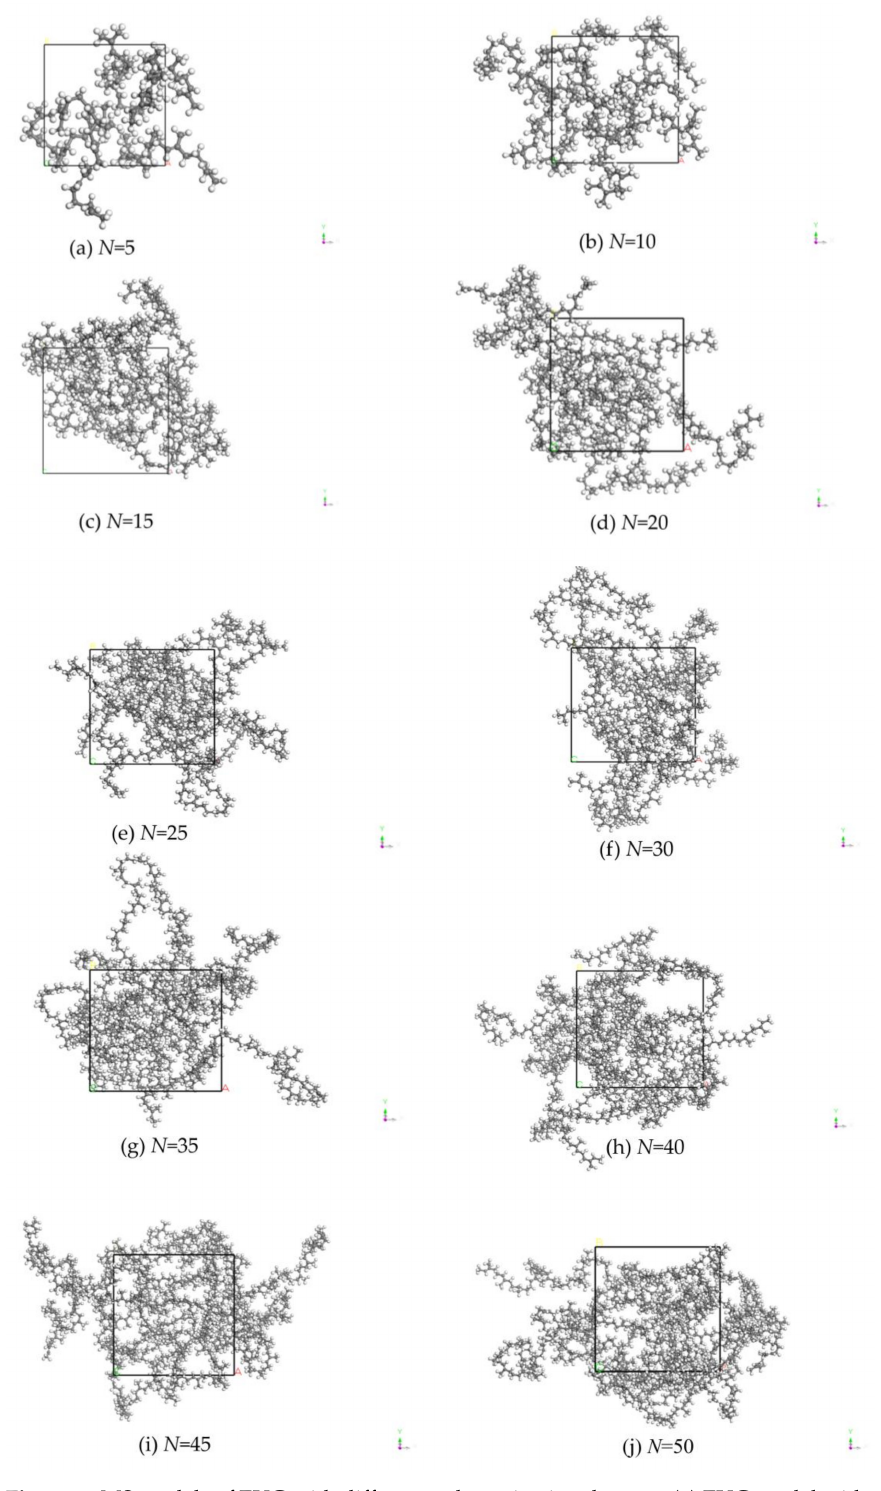
Figure 7. MS models of EUG with different polymerization degrees. ( a ) EUG model with aggregation degree of 5; ( b ) EUG model with aggregation degree of 10; ( c ) EUG model with aggregation degree of 15; ( d ) EUG model with aggregation degree of 20; ( e ) EUG model with aggregation degree of 25; ( f ) EUG model with aggregation degree of 30; ( g ) EUG model with aggregation degree of 35; ( h ) EUG model with aggregation degree of 40; ( i ) EUG model with aggregation degree of 45; ( j ) EUG model with aggregation degree of